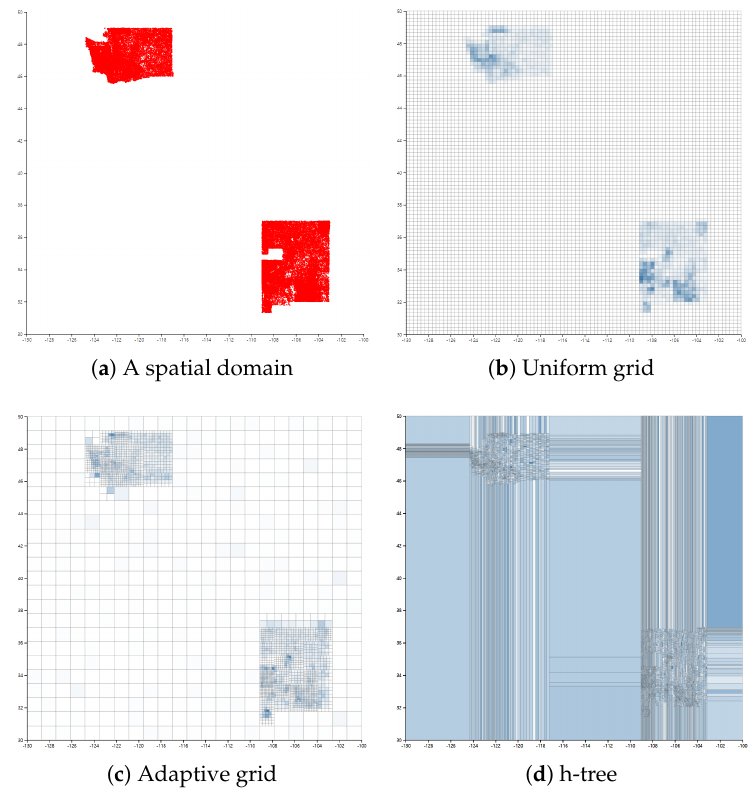
Figure 4. Examples of a spatial domain and various corresponding PSD